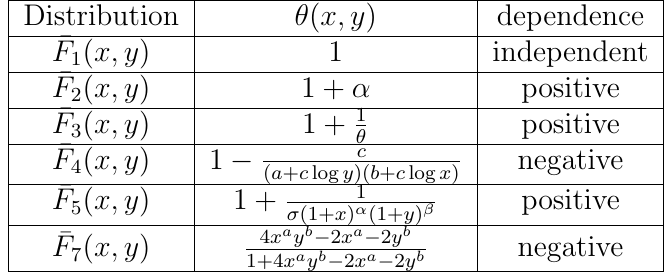
Clayton measure for bivariate Pareto